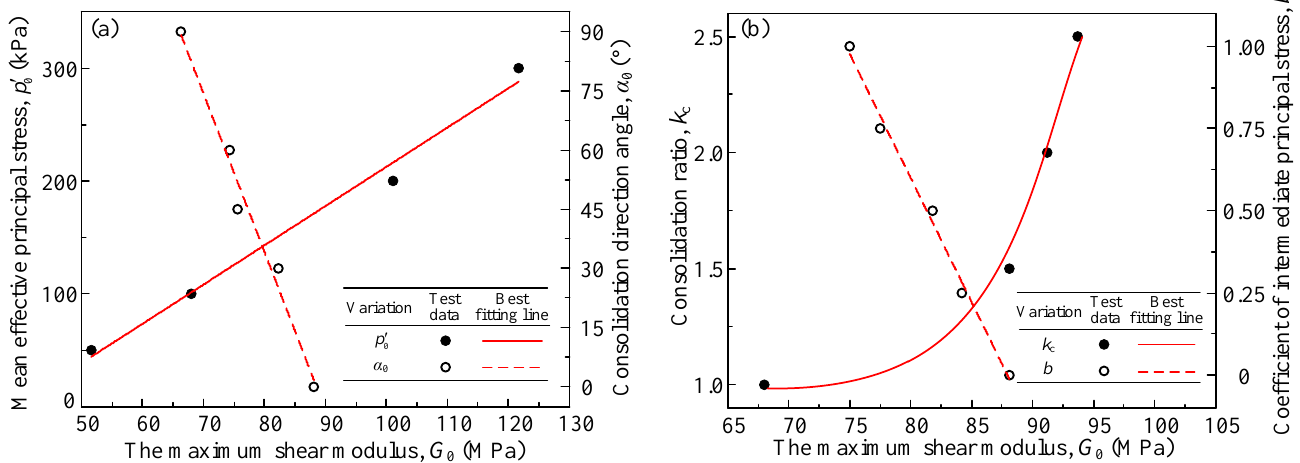
Figure 7. The correlations between the experimental G 0 and various consolidation parameters under various ( a ) effective mean principal stress and consolidation direction angle, ( b ) consolidation ratio and coefficient of intermediate principal stress.